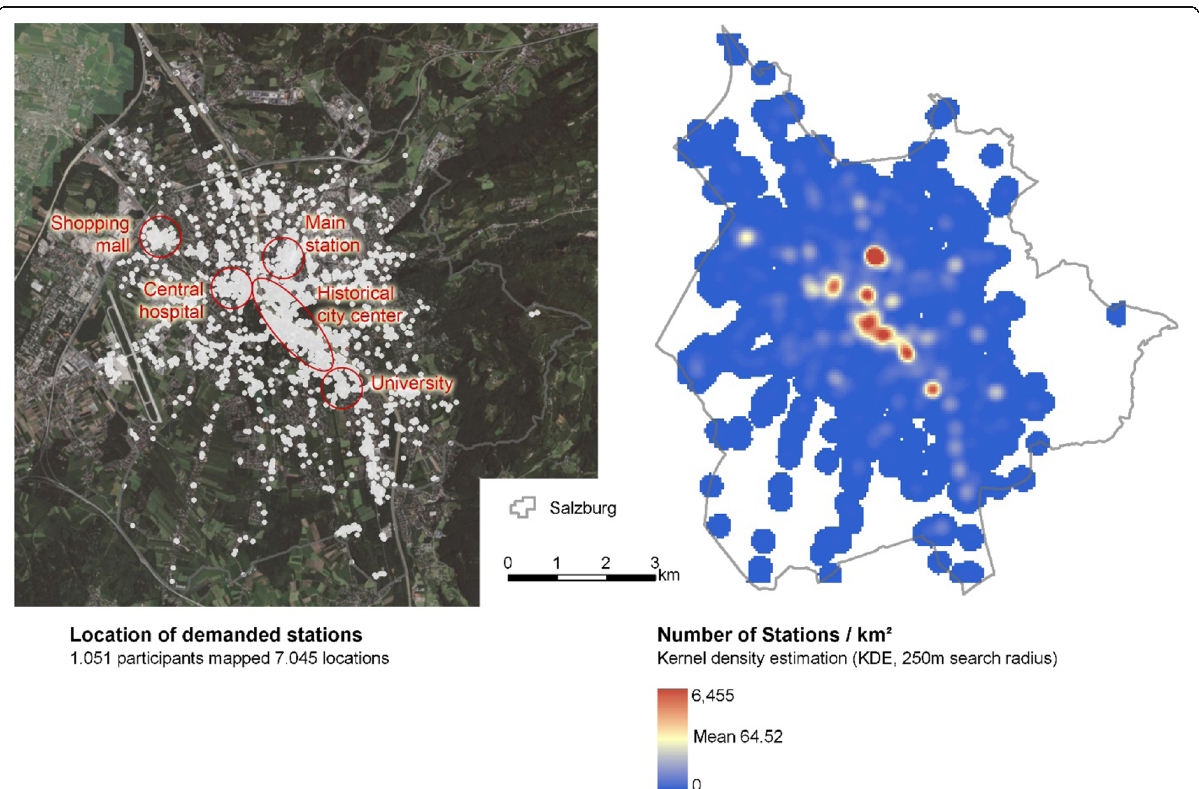
Fig. 6 Result of the map-based, online survey: mapped station locations (left) and result of a kernel density estimation for clustering